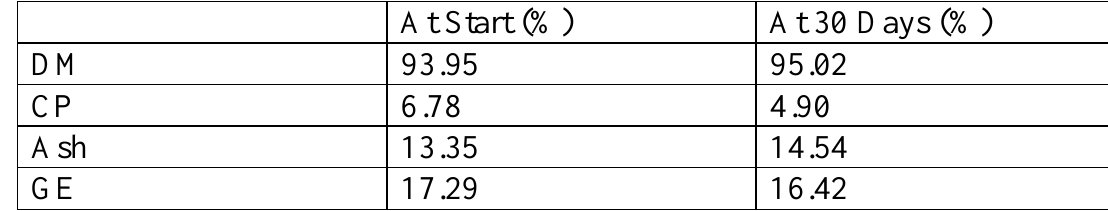
Table 2: Chemical analysis of cereal